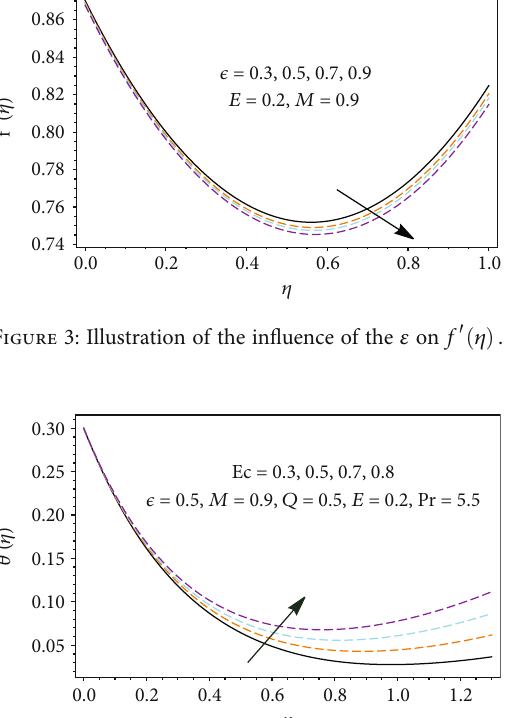
Figure 8: Illustration of the in fl uence of the electric fi eld parameter on temperature pro fi